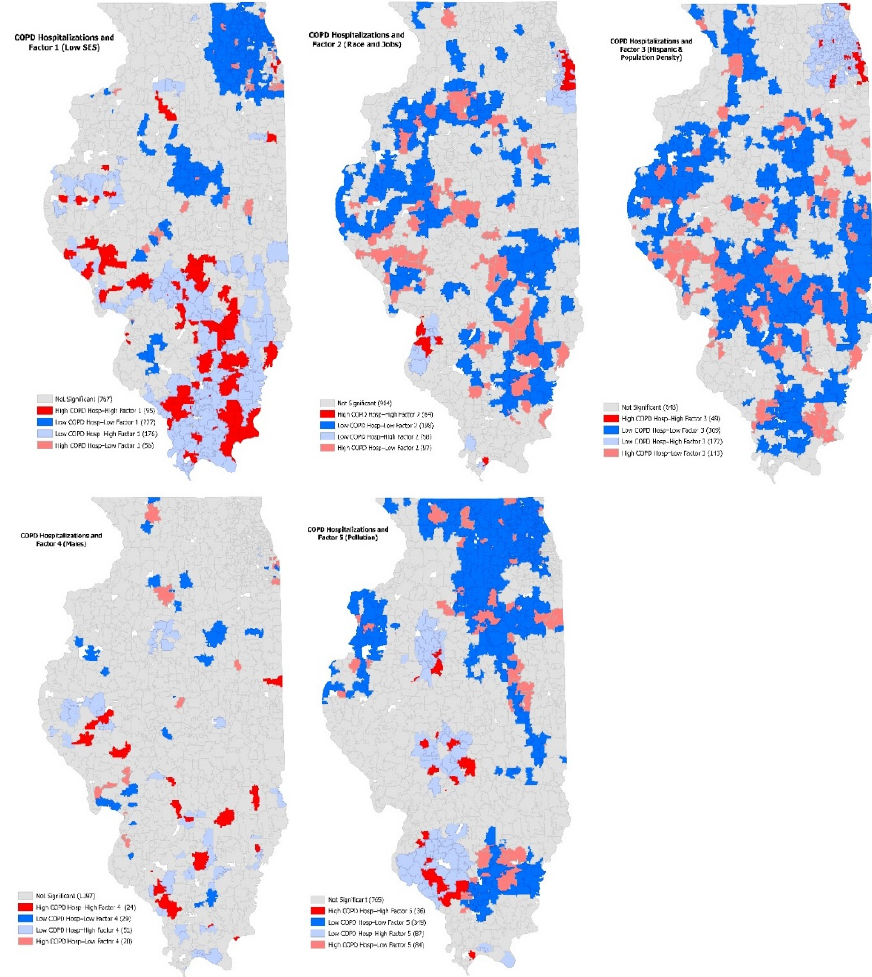
Figure 3. Bivariate LISA maps for each component and age-adjusted COPD hospitalization rate.